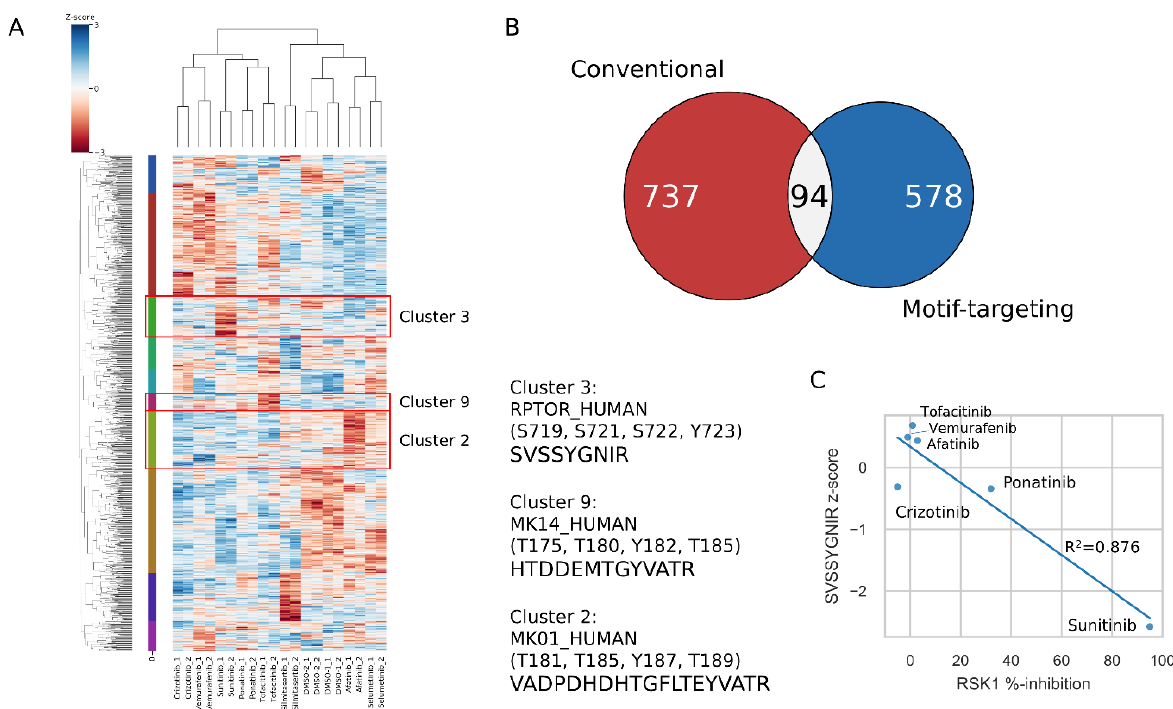
Figure 5. Clustering analysis of significantly changed peptides. ( A ) The heatmap shows the cluster- ing results for significantly changed peptides. The peptides are clustered into ten groups. Several candidate peptides representing each cluster are shown. ( B ) The overlap of significantly regulated peptides identified in the conventional workflow and motif-targeting workflow. ( C ) The relationship between %-inhibition of RSK1 [36] and the z-scores from the quantitative results.